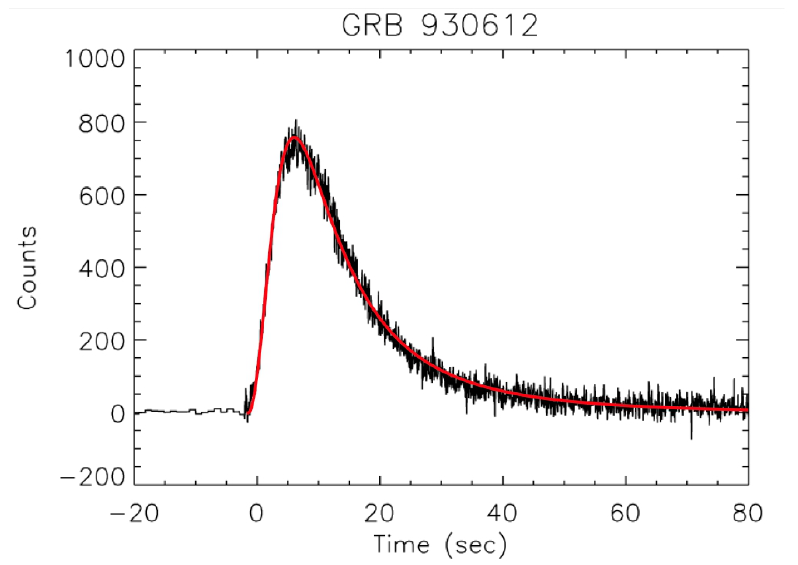
Figure 6. The pulse shape of GRB930612 measured with BATSE aboard CGRO and the shape given by Equation (6) for ∆ = 7.1 s and τ = 70.1 s, the best CB-model fit to re-bined data.